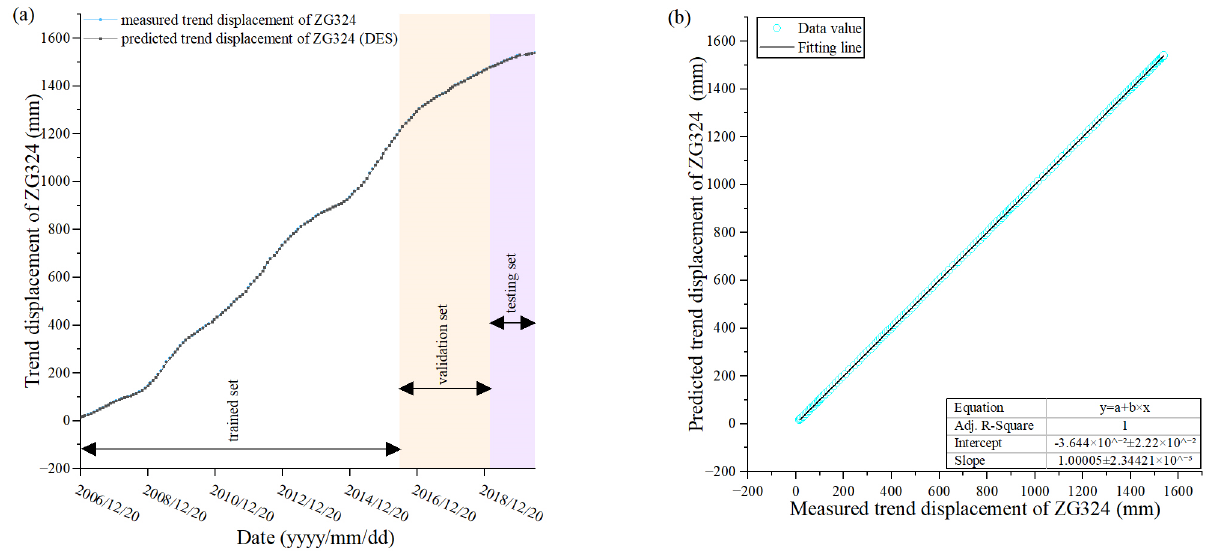
Figure 12. ( a ) Testing results of DES-model for trend displacement, ( b ) agreement of the predicted and measured trend displacement.